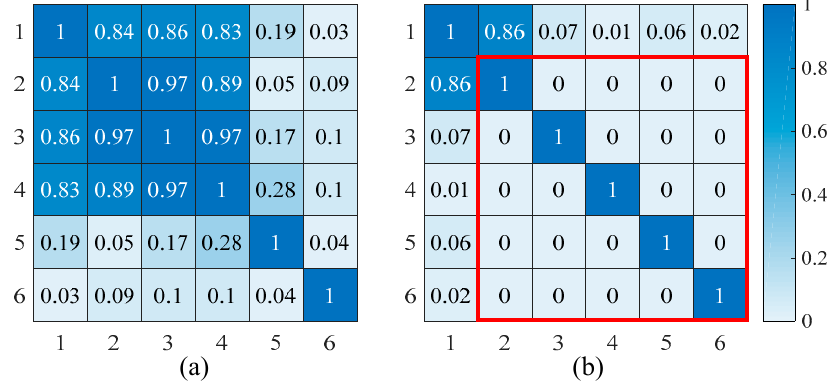
Figure 1. The heatmap of the correlation matrix compares the correlation between the factors before and after principal component analysis (PCA): ( a ) the correlation coefficient of the factors; ( b ) the correlation coefficient of the components extracted by PCA.